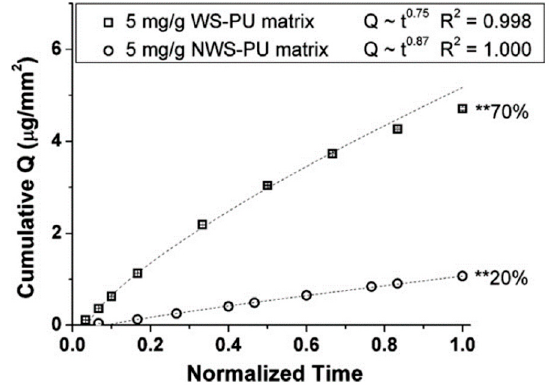
Figure 2. Cumulative flux (Q) of dapivirine as a function of time from a water swelling (WS-PU) and non-water swelling (NWS-PU) polyurethane matrix. ** denotes wt % cumulative release of dapivirine over 30 days. Adapted from [14], Elsevier, 2010 with permission.